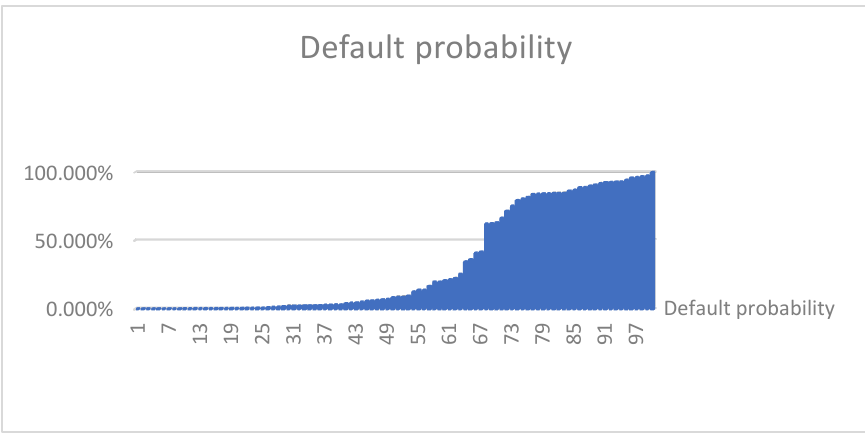
Figure 1. Distribution of the 100 borrowers’ default probability.